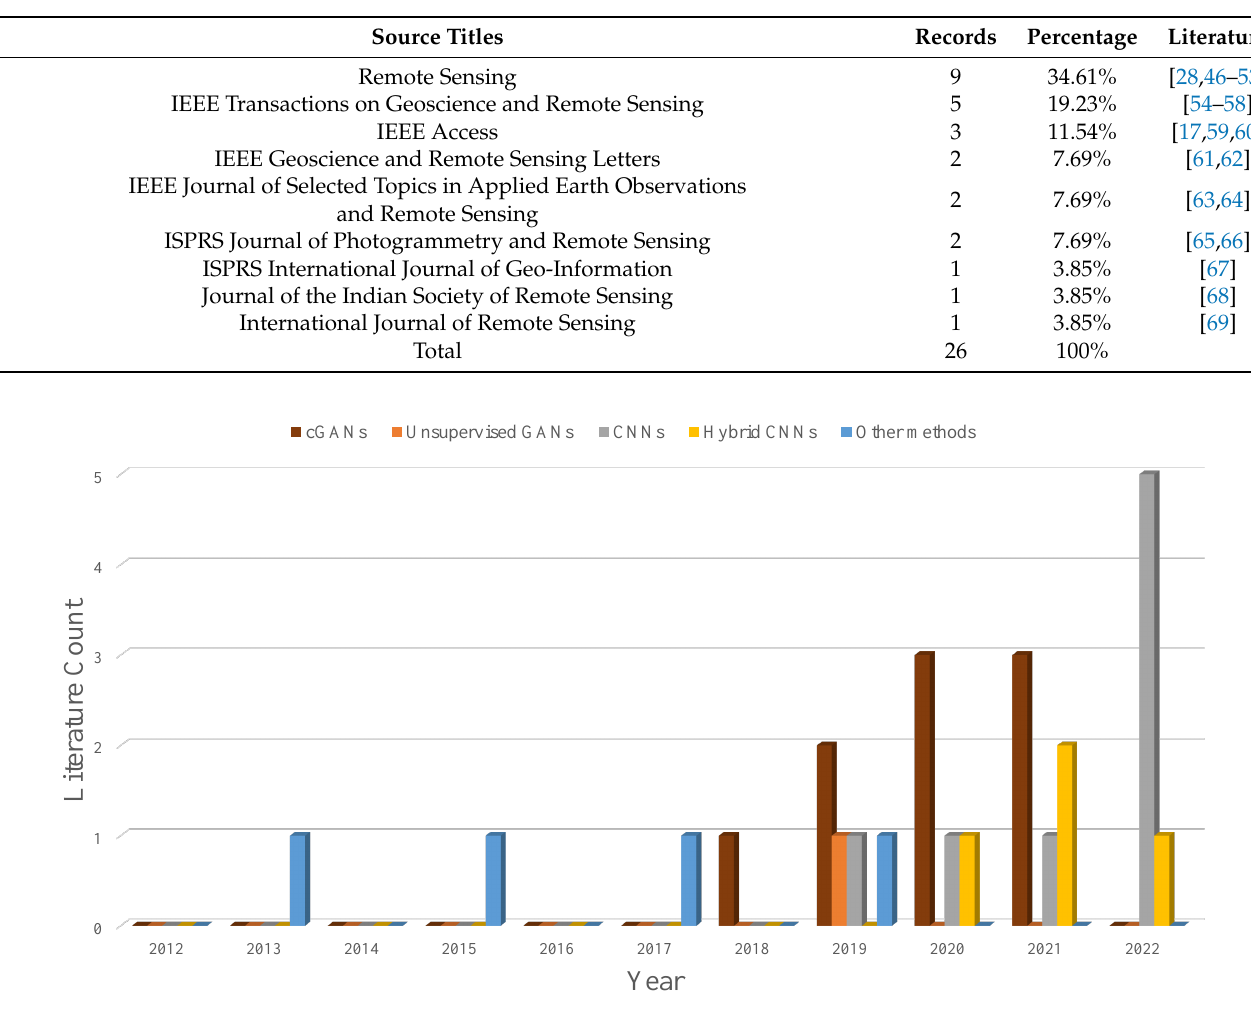
Table 1. Number of papers published in 9 journals using SAR for cloud removal. The search was conducted on 20 November 2022.